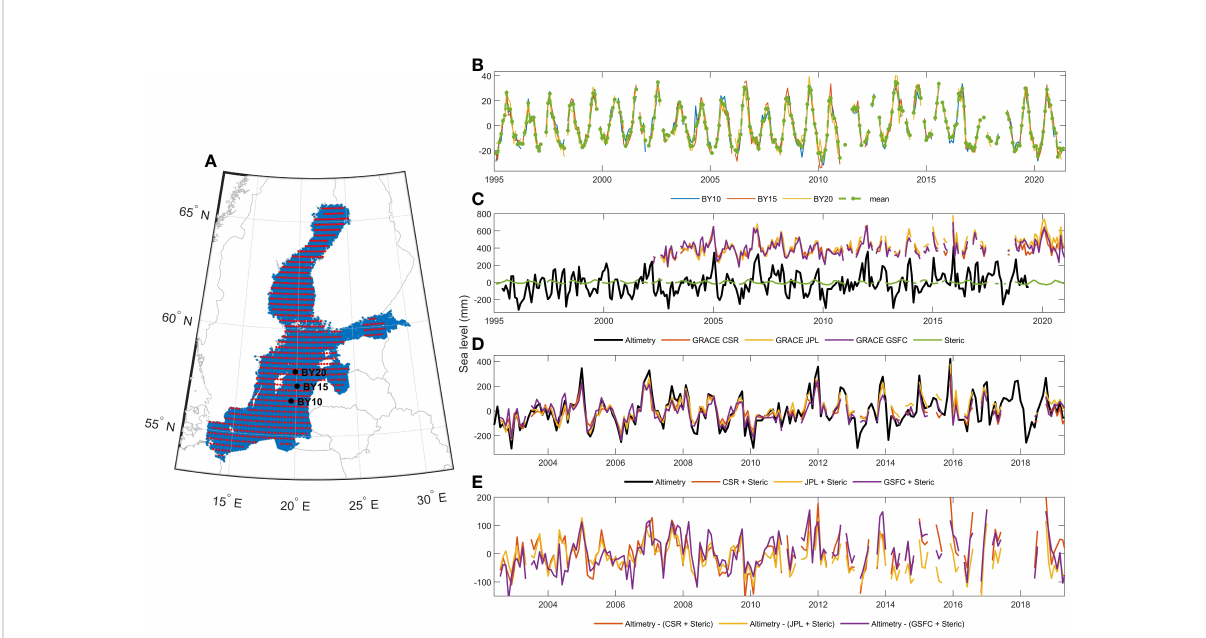
FIGURE 1 Datasets used in the study: (A) The extent of altimetry (blue), GRACE CSR (red), and location of the stations for subsurface salinity and temperature data. (B) Estimated steric sea level from three stations. (C) Total sea level (altimetry), barystatic (GRACE mascons from CSR, JPL, GSFC), and steric sea level. The barystatic data is shifted by arbitrary value for visual presentation. (D) Comparison of total sea level (altimetry) to sum of contributors (Eq. 1) and, (E) Residuals ( ϵ ) of Eq.